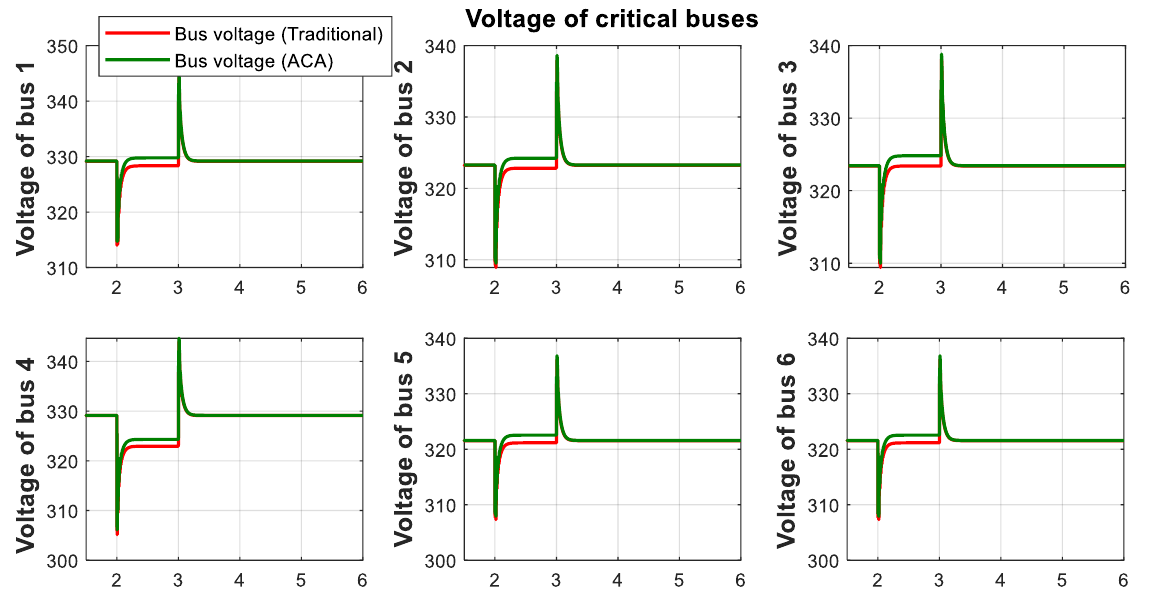
Figure 20. Average Voltage of Critical Buses with and without ACA after a Load Change at Bus 4.